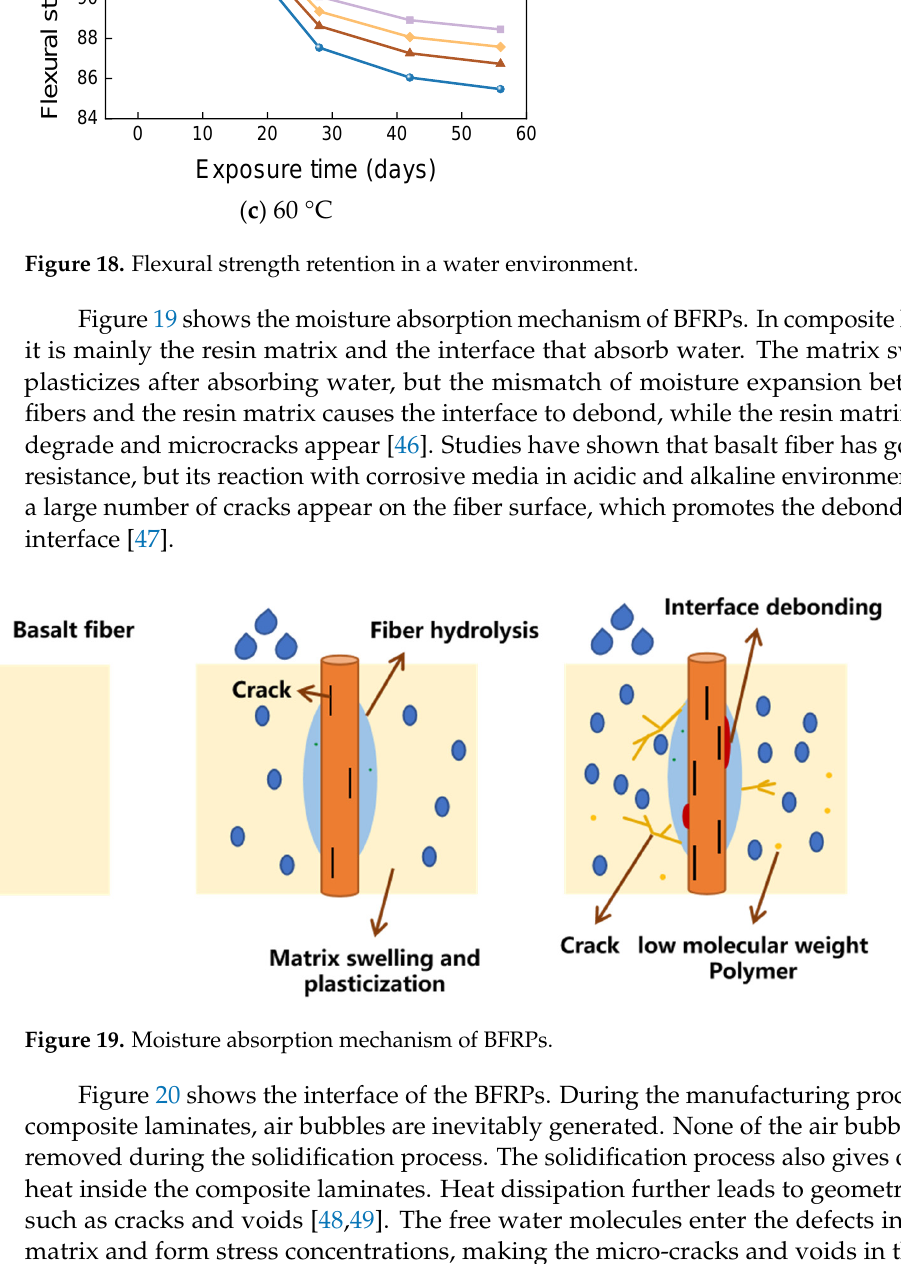
Figure 19. Moisture absorption mechanism of BFRPs.